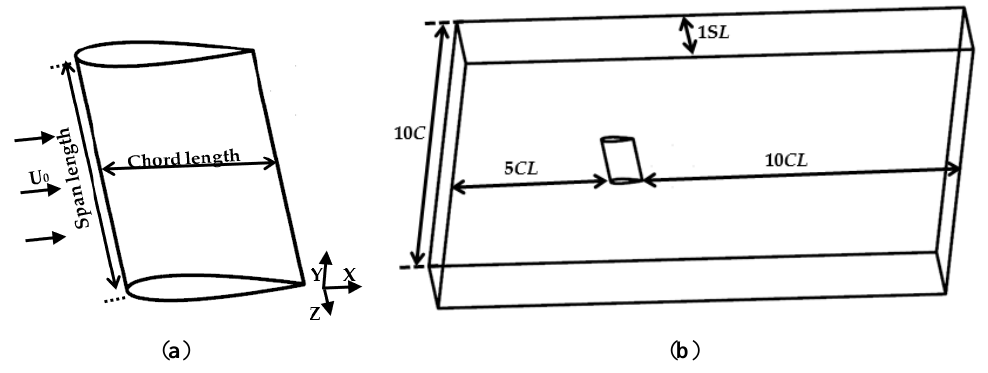
Figure 2. Model and calculation domain. ( a ) NACA0018 blade; ( b ) Calculation 2. The figure needs to be aligned with the text below (red line position).